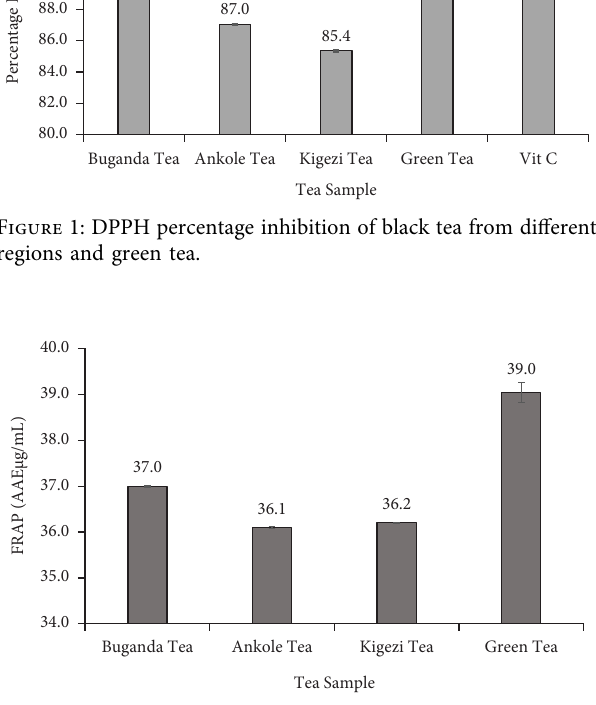
Figure 2: Ferric reducing assay power of black tea from diferent regions and green